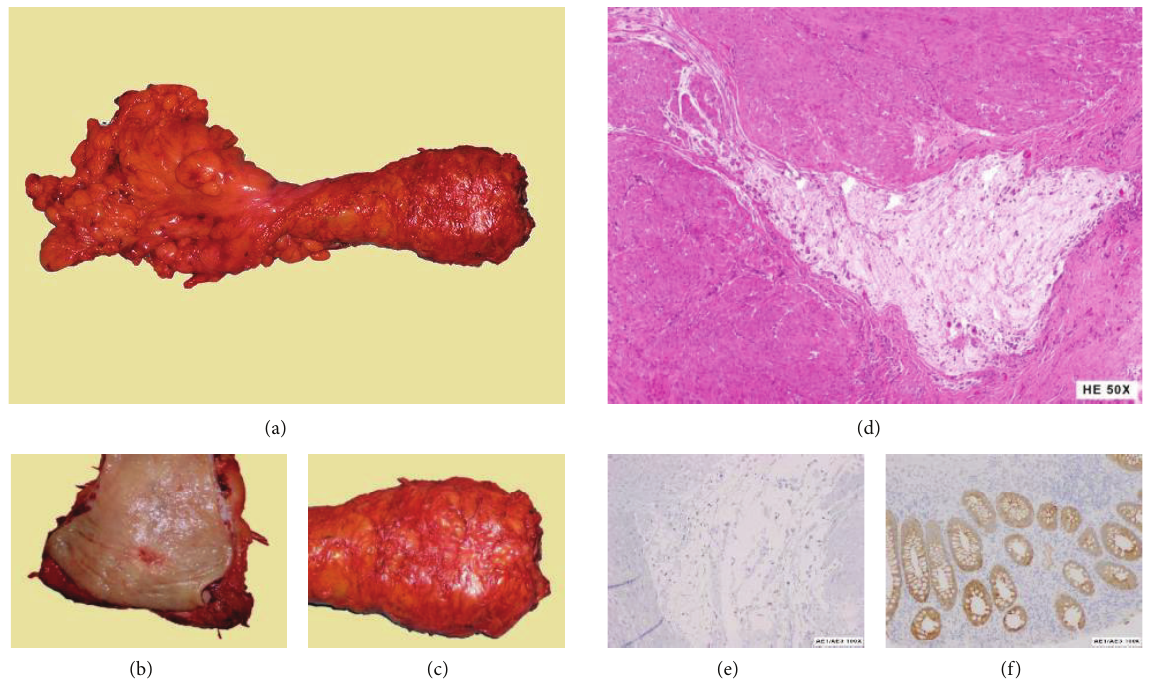
Figure 4: Resected specimen and histological result. (a) Resected specimen; (b) and (c) details of resected specimen; (d) mucin pools with histiocytes in muscular layer but no malignant epithelium; (e) and (f) immunohistochemistry analysis with cytokeratin AE1/AE3 confirms the absence of malignant